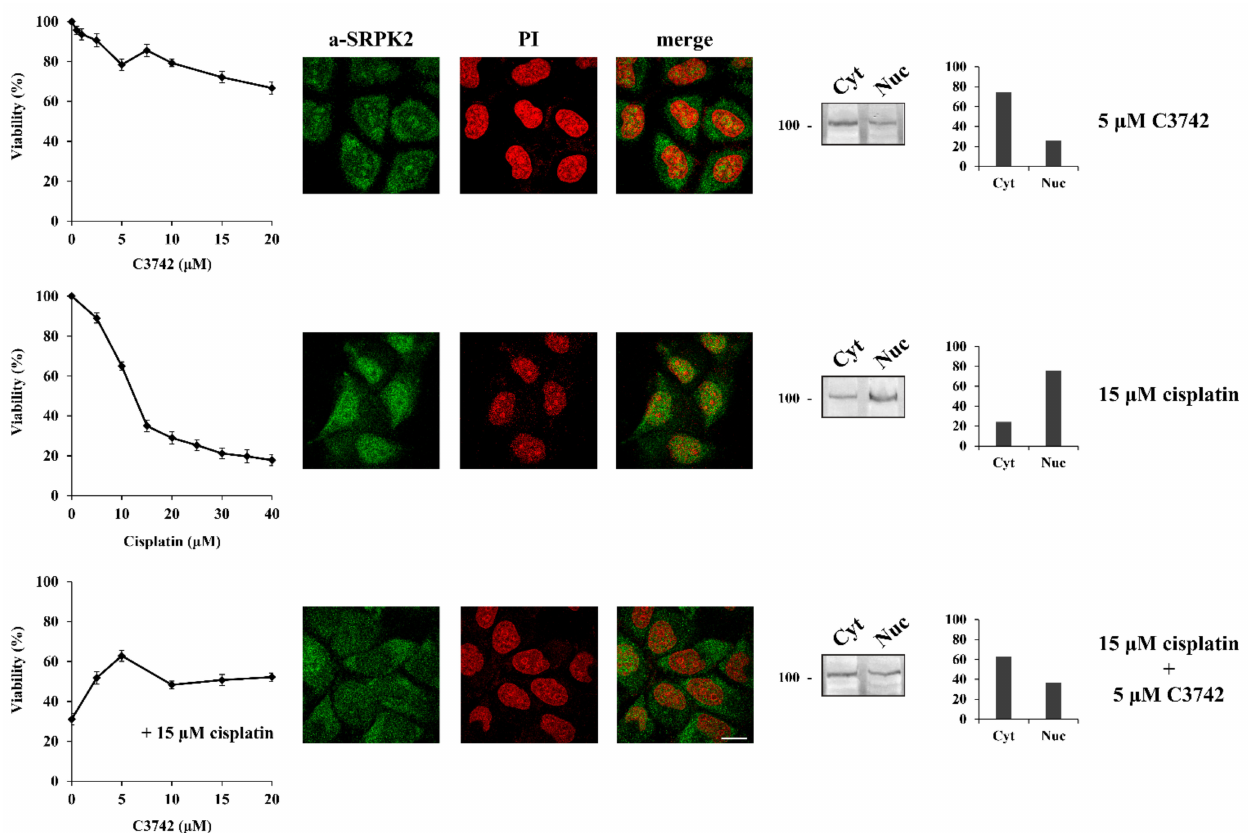
Figure 3. Chk2 inhibition prevents the nuclear translocation of SRPK2 in cisplatin-treated cells and significantly protects the cells from drug cytotoxicity. HeLa cells were treated with increasing concentrations of C3742 (0.5–20 µ M) alone, cisplatin (5–40 µ M) alone, and cisplatin (15 µ M) combined with increasing concentrations of C3742 for 24 h. The number of viable cells was measured with an MTT assay ( left panel ). Viable cells were quantified by normalizing the absorbance readings to the untreated control cells, which was set as 100% viability. Correspondingly, HeLa cells were treated with C3742 (5 µ M) alone, cisplatin (15 µ M) alone, and cisplatin (15 µ M) combined with C3742 (5 µ M) for 24 h and subjected to immunofluorescence staining with the anti-SRPK2 monoclonal antibody ( middle panel ). Nuclei were stained with PI. Scale bar: 10 µ m. The distribution of SRPK2 after each treatment was also determined by a cell fractionation procedure ( right panel ). SRPK2 was detected in cytoplasmic (Cyt) and nuclear (Nuc) extracts by Western blotting using the anti-SRPK2 monoclonal antibody. The nuclear-to-cytoplasmic SRPK2 ratios in the Western blots shown were quantified using ImageJ